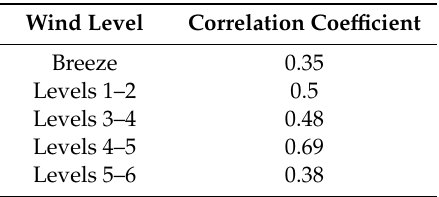
Table 4. Correlation coe ffi cients between UA triggering frequency and wind